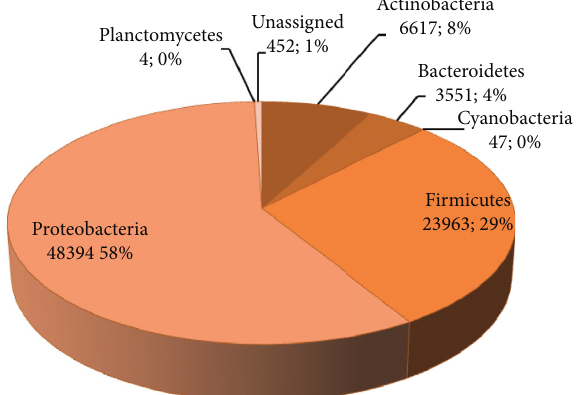
Figure 1: Six phyla of bacteria found in A. nigrocincta